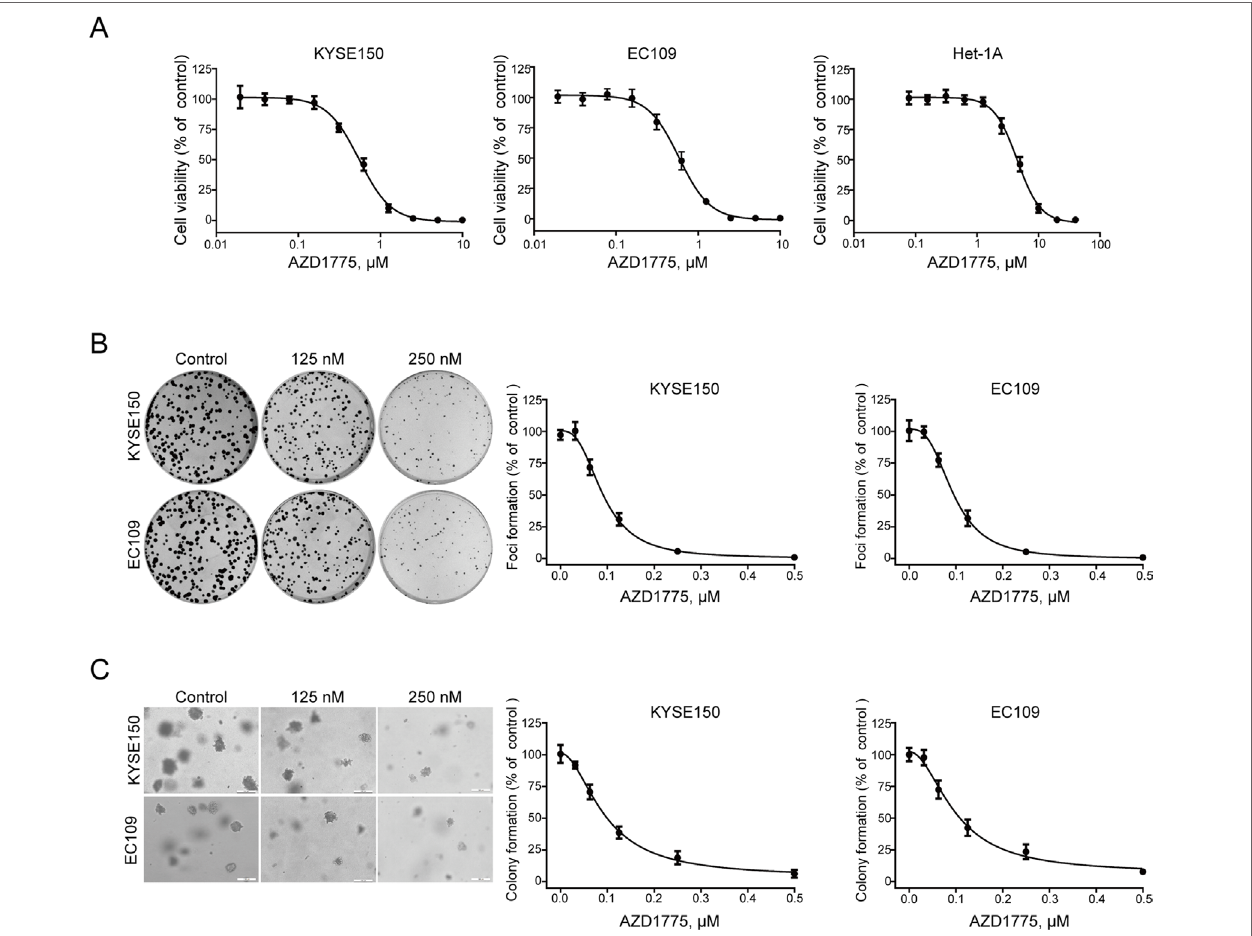
FIGURE 2 | AZD1775 diminishes the growth of ESCC cells in vitro. (A) KYSE150 and EC109 cells were incubated with various concentrations of AZD1775 for 72 h. Cell viability was determined with MTT assay. Data from five independent experiments were shown. (B, C) KYSE150 and EC109 cells were exposed to increasing concentrations of AZD1775 for 48 h. The cells were then washed and subjected to focus colony formation (B) and soft agar assay (C) and incubated for 14 days, survival colonies were then counted. Data are expressed as mean ± SD, from six independent